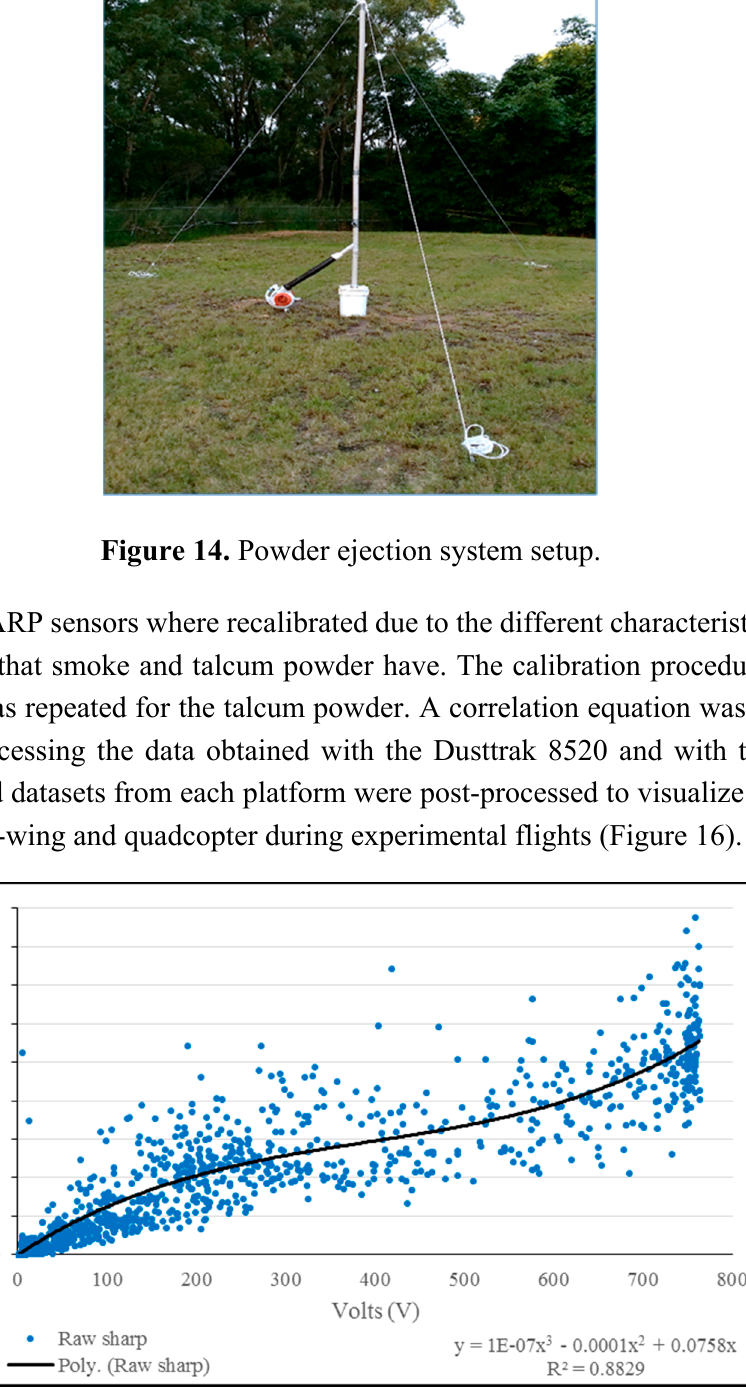
Figure 15. Correlation between talcum powder particles and raw value readings from the SHARP sensor and